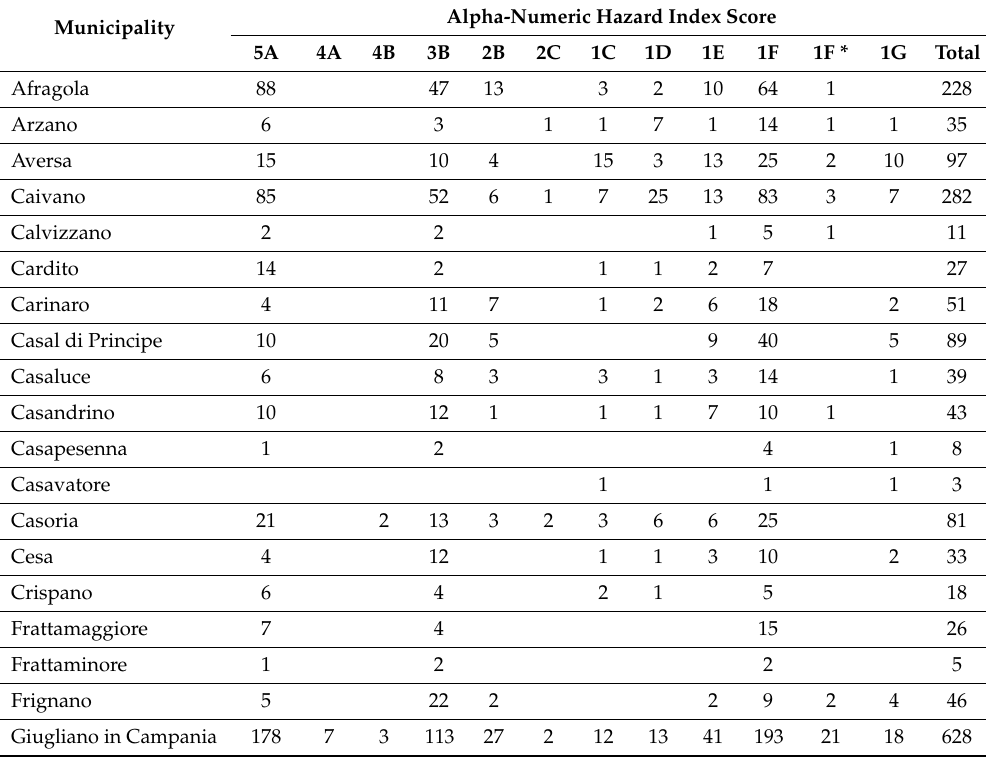
Table 3. Municipal distribution of waste sites, by hazard